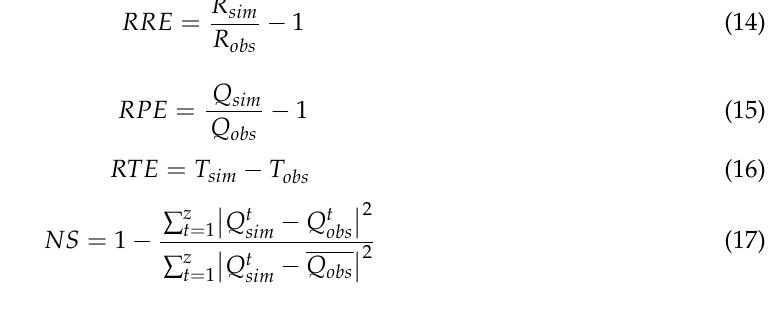
Table 1. Statistics of flood